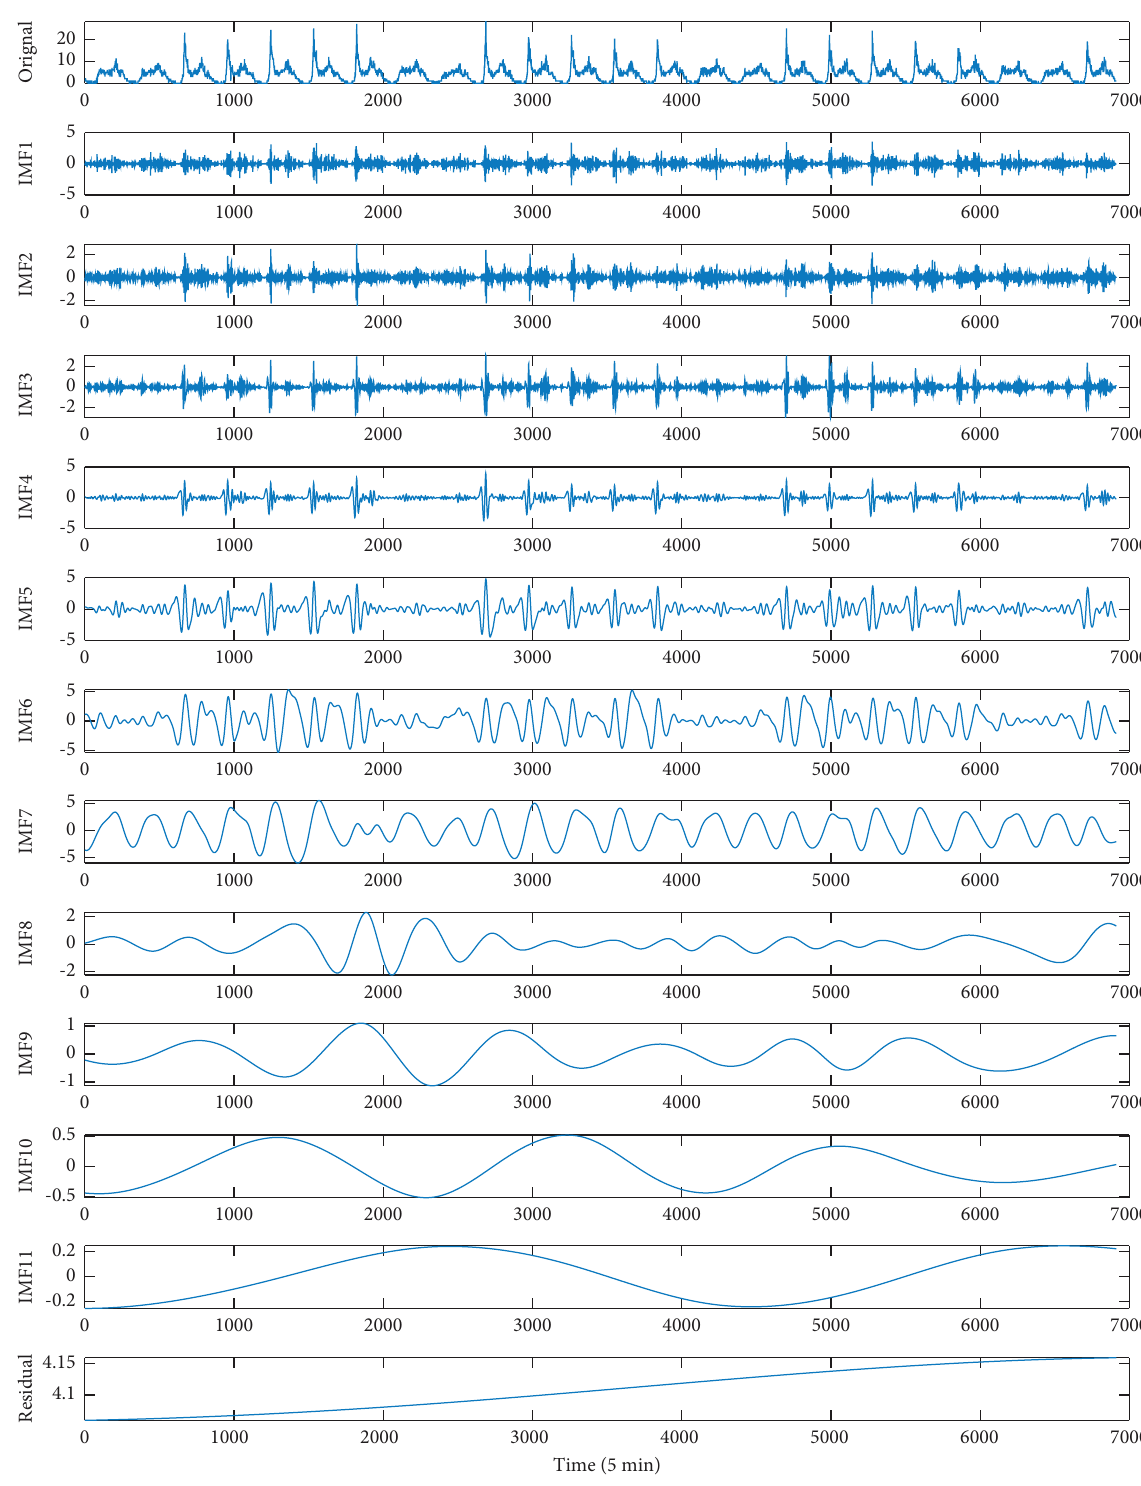
Figure 5: IMF components extraction by